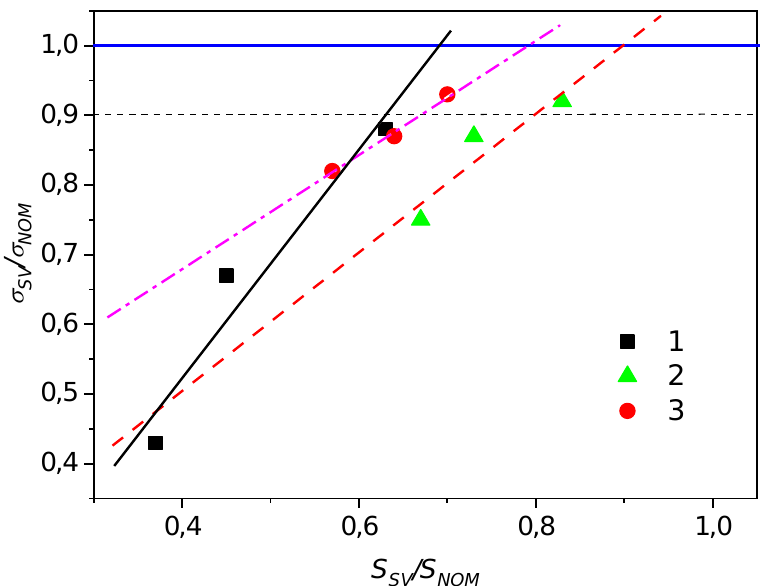
Figure 7. Dependence of values of relative strength of the welded joints on the relative areas of the welded cross-sections; 1, 2, 3—initial and two reinforced 1550 alloy.